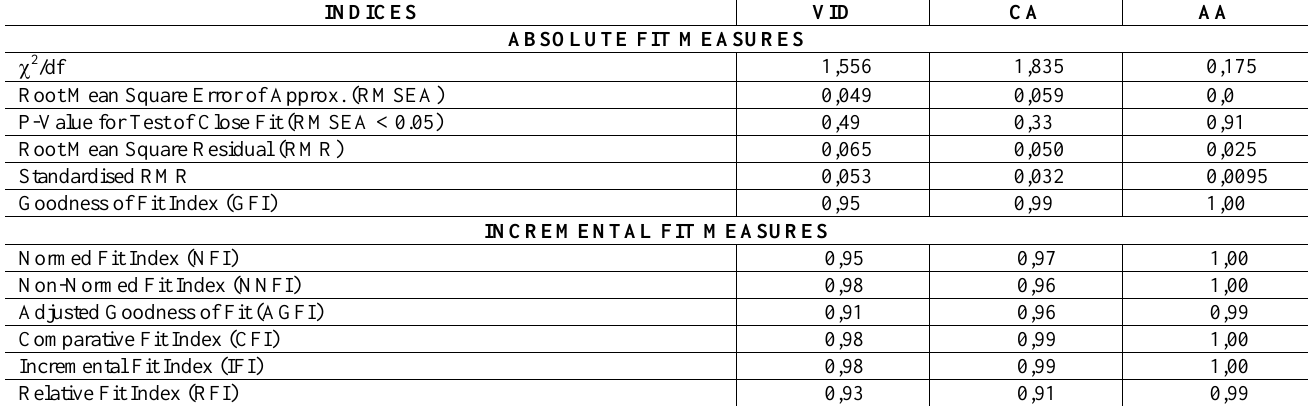
Table 1: Confirmatory factor analysis fit indices obtained for the refined CDBS measurement models